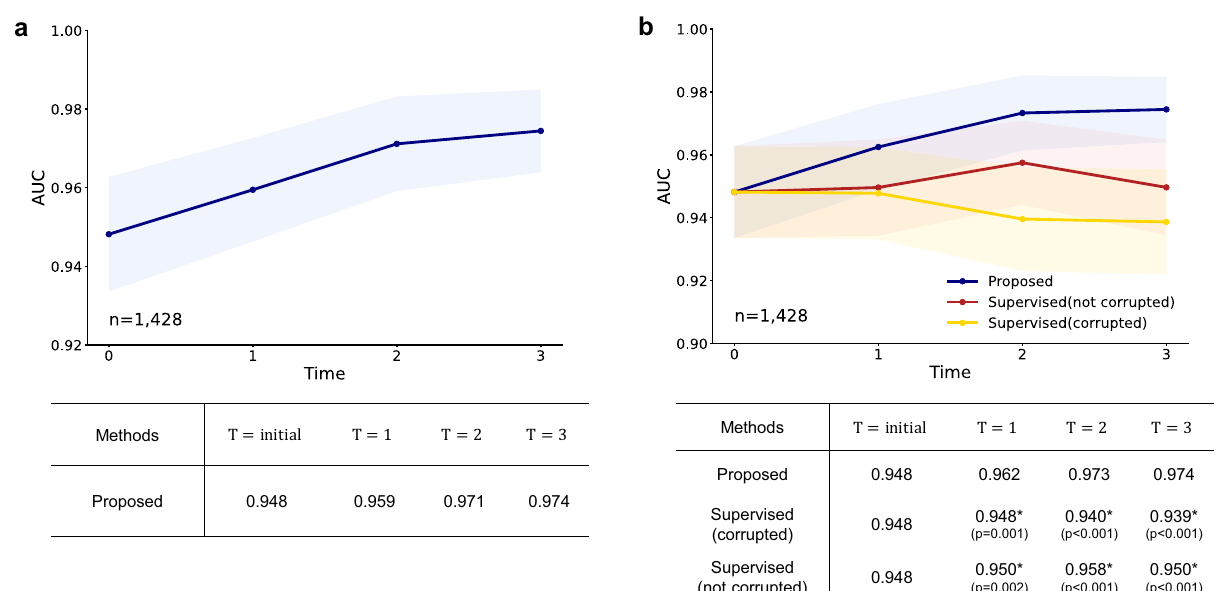
Fig. 5 Tuberculosis diagnosis results with real-world data collection and label corruption. a Even after adding unseen class data that are commonly encountered in clinics, the performance was stably improved with increasing time T , even though these other class data were not included for the training of the initial model. b In the simulation for label corruption, the model trained with the proposed framework was not compromised, while the model trained with supervised learning using corrupted labels showed signi fi cant deterioration in performance. Data are presented with calculated area under the receiver operating characteristics curves (AUCs) in the study population (center lines)±95% con fi dence intervals calculated with the DeLong's method (shaded areas). The AUCs of the proposed method and the supervised learning method with and without corruptions were compared at each time point T with the DeLong test to evaluate statistical signi fi cance, except for the T = initial where all methods start from the same baseline. * denotes statistically signi fi cant ( p < 0.050) superiority of the proposed framework. All statistical tests were